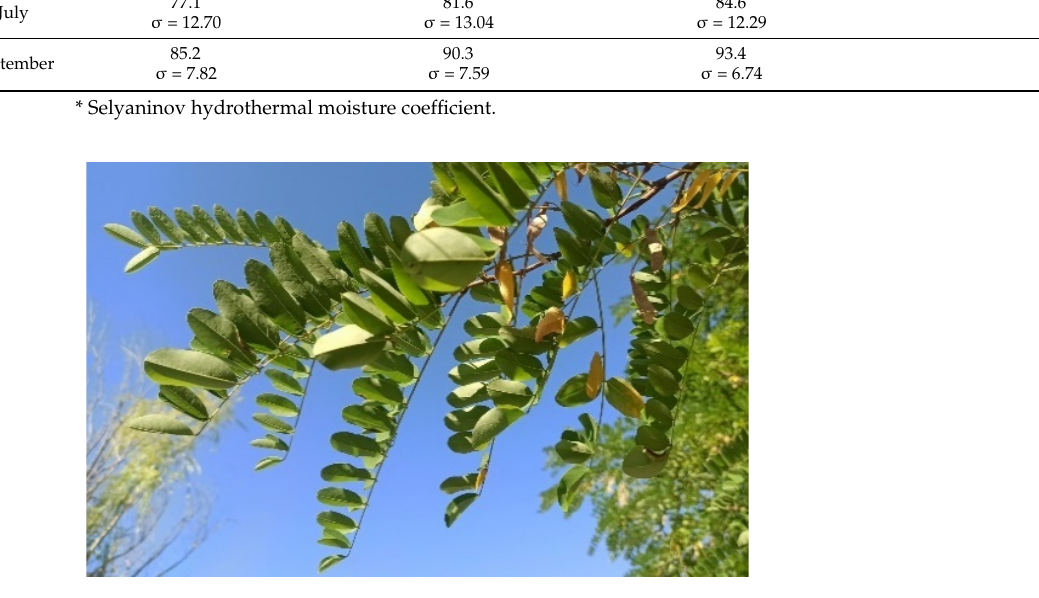
Figure 6. Folding of leaflets of a complex leaf of R. neomexicana under the influence of high tempera- ture and light.